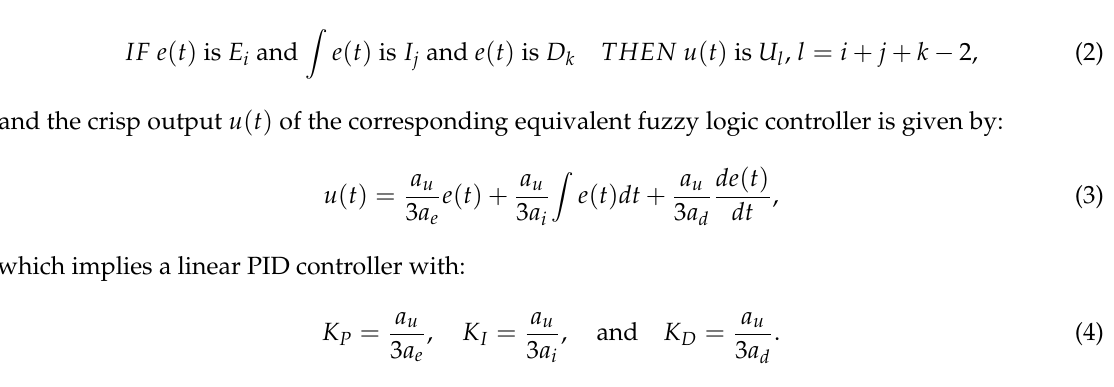
Figure 1. Graphical definition of MFs for fuzzy variables, e ( t ) ,